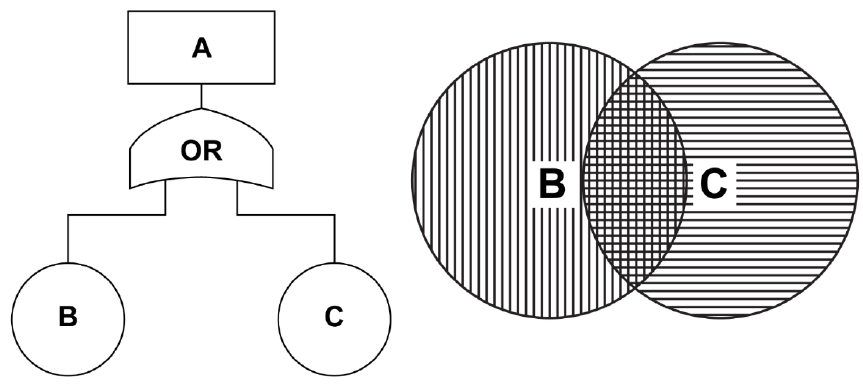
Figure 3. Logic of OR gate for fault tree analysis (FTA).